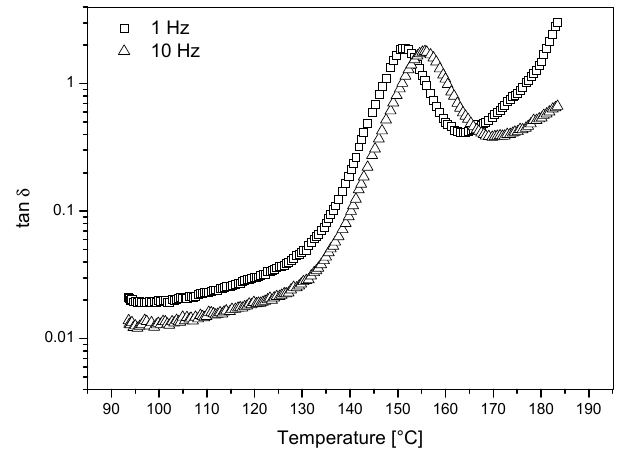
Figure 7. Tan δ versus temperature for PC used as modifier in PEI/PC blends tested at two different frequencies (i.e., 1 Hz and 10 Hz).